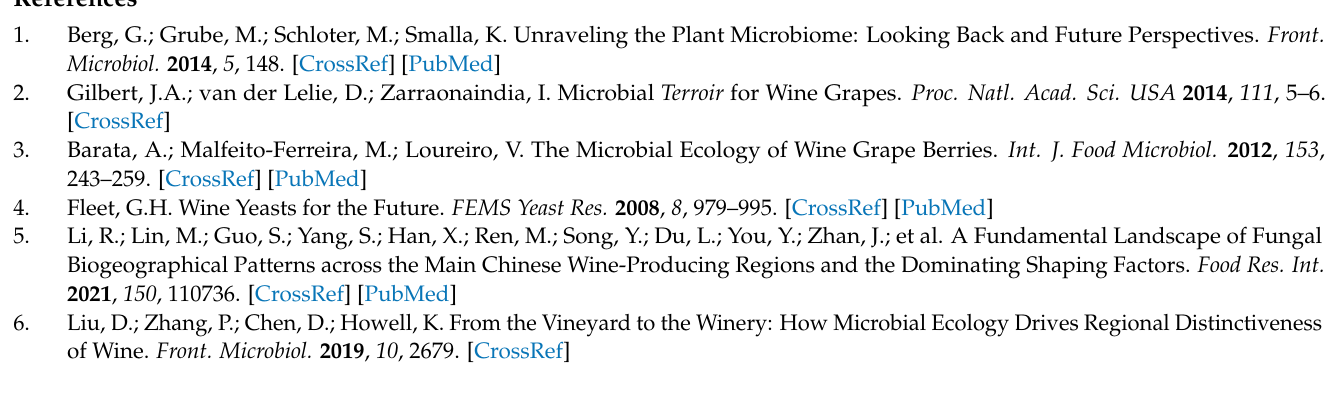
Categories of morphotypes of yeast strains isolated from grape spontaneous fermentation. Table S4: Colony numbers and percentage (%) of Saccharomyces isolates and genotypes during wine sponta- neous fermentations with/without SO 2 addition. Table S5: Concentration ( µ g/L) of volatile com- Table S6: Concentration ( µ g/L) of volatile compounds in Chardonnay wines fermented by indigenous S. cerevisiae with varying